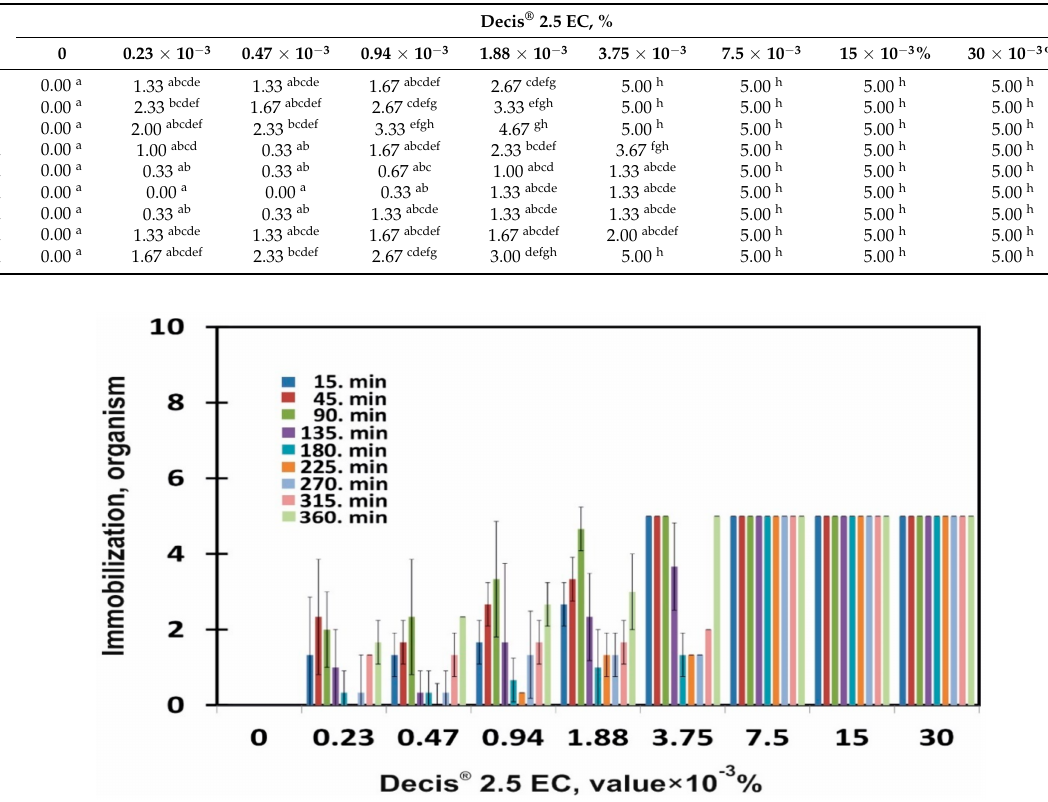
Figure 2. Immobilization of ostracod ( Heterocypris incongruens ) exposed to Decis ® 2.5 EC concentra-